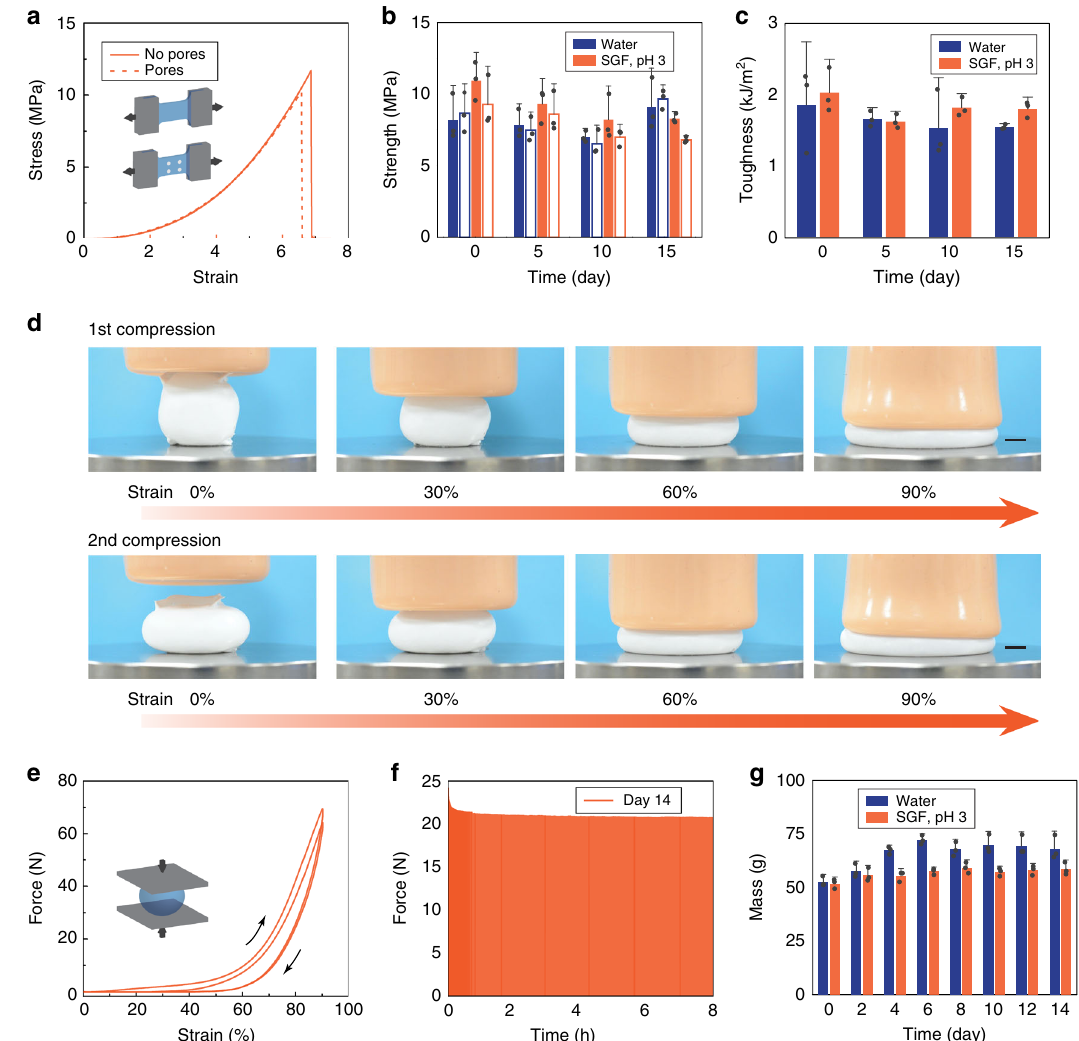
Fig. 3 Mechanical robustness of the ingestible hydrogel device. a True stress – stretch curves of the polyvinyl alcohol hydrogel membranes with and without pores, which have been immersed in SGF (pH 3) at 37 °C for 12 h. b Tensile strength of the hydrogel membranes with (open) and without ( fi lled) pores, which have been immersed in water or SGF (pH 3) at 37 °C for 0 – 15 days. c Fracture toughness of the hydrogel membranes, which have been immersed